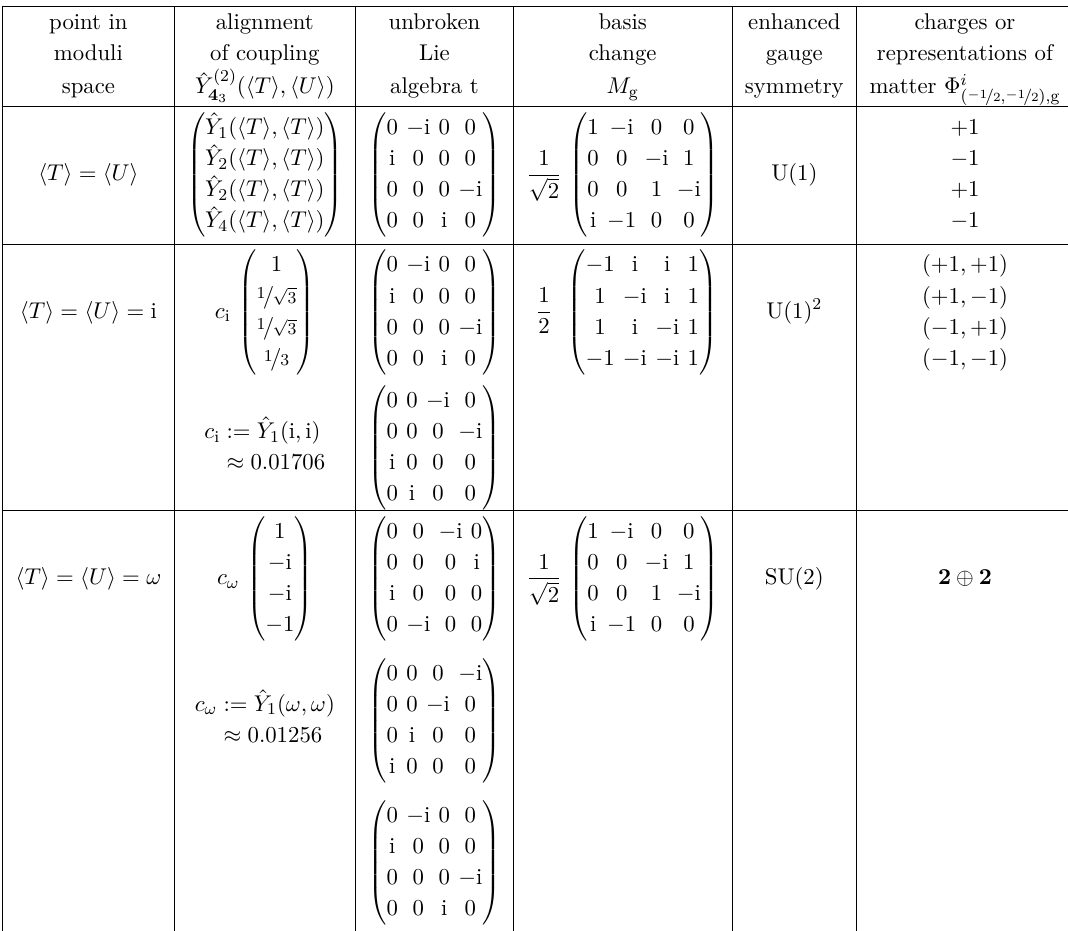
Table 2. Gauge symmetry enhancements by Lie algebra elements t in the case of the T 2 / Z 2 orbifold sector at special points in moduli space, uncovered as “accidental” symmetries of the superpotential due to the alignment of couplings in flavor space. Note that the field basis of twisted matter fields Φ i with well-defined gauge charges differs from the field basis of localized twisted strings ( − 1 / 2 , − 1 / 2 ) , g Φ i using the basis change M in eq. g ( − 1 / 2 , − 1 / 2 )